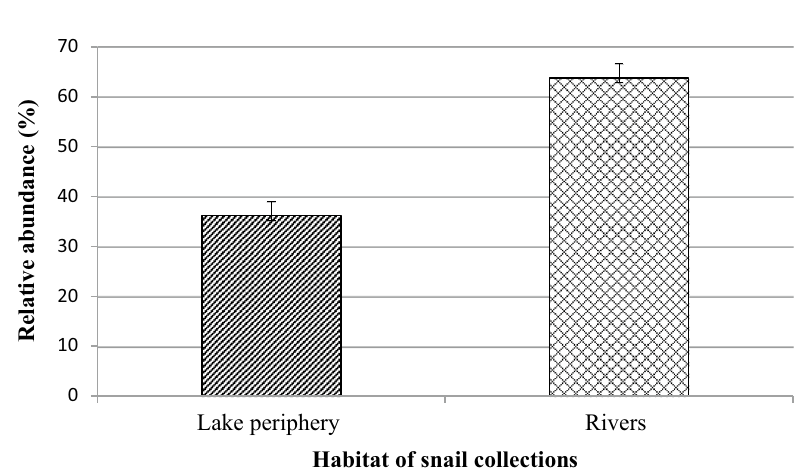
Figure 6. Relative abundance of Biomphalaria snails at study habitat.